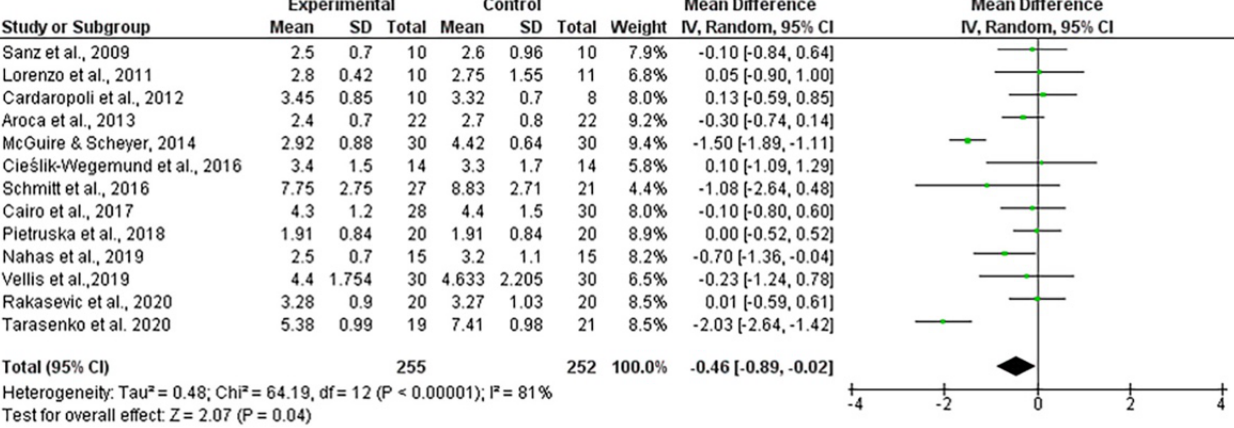
Figure 7. ( a ) Funnel plot for keratinized mucosa width when using autogenous connective tissue. The estimated keratinized mucosa width measurement is on the horizontal axis and study precision (standard error) appears on the vertical axis. ( b ) Funnel plot for keratinized mucosa width in studies using collagen matrix. The estimated keratinized mucosa width measurement is on the horizontal axis and study precision (standard error) appears on the vertical axis.